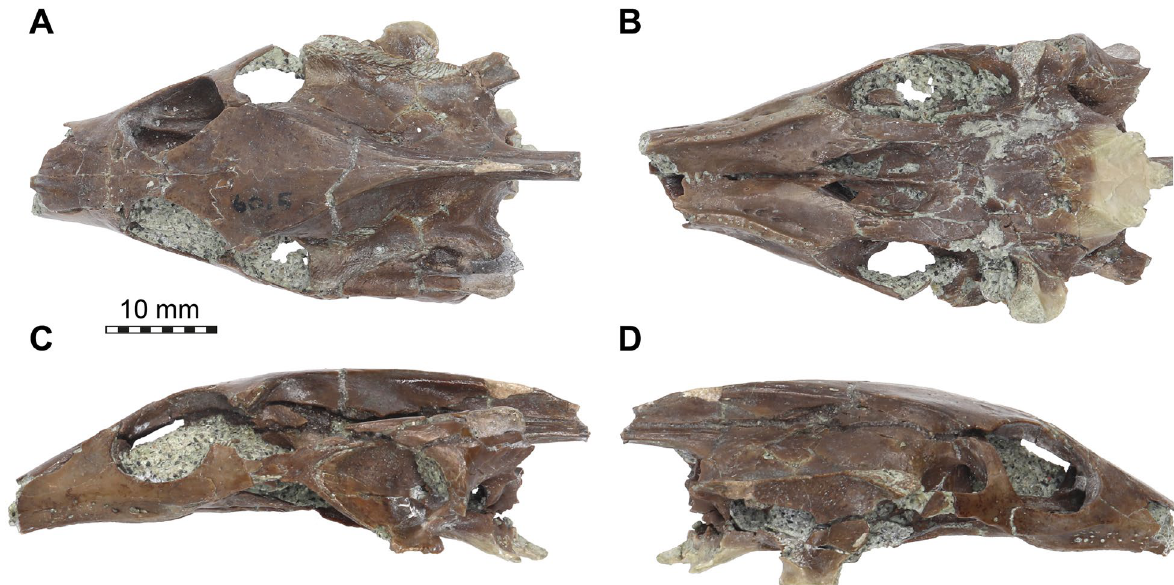
Fig. 1 Photographs of the cranium of Plastomenus thomasii (AMNH FR 6015). A dorsal view. B ventral view. C left lateral view. D right lateral